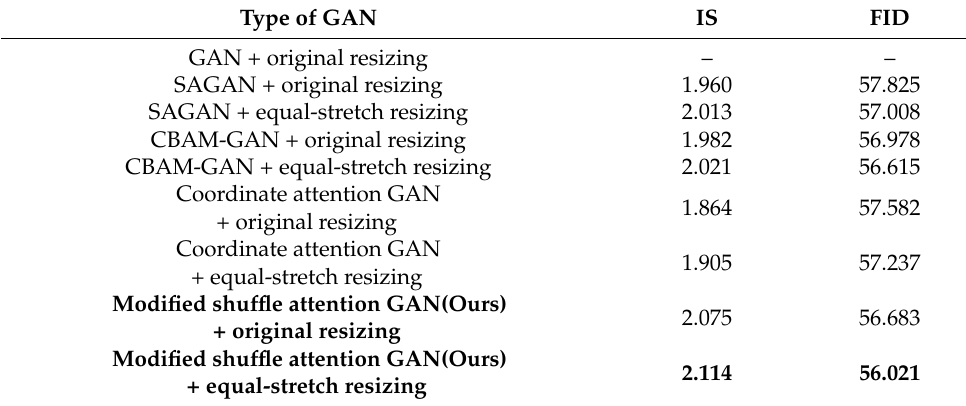
Table 1. IS and FID scores of generated pictures of different GAN